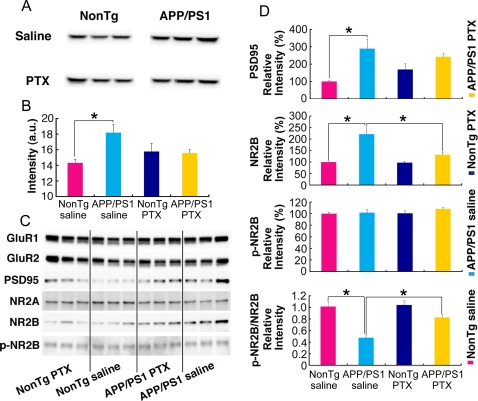
Modification of synaptic protein levels in adult APP/PS1 mice by PTX treatment.The effect of 10-day PTX treatment on the protein level of GABAA receptor α1 subunit was examined by Western blot analysis of brain homogenates. (A, B) Immunoreactivity against the GABAA receptor α1 subunit, as demonstrated by Western blotting, showed that the excess amount of this subunit in saline-treated APP/PS1 mice in comparison with the amount in saline-treated nonTg mice was absent in PTX-treated animals; *p = 0.0274, two-tailed Student's t-test. (C, D) Western blotting of membrane fractions from four groups of mice. Blots probed with antibodies against various receptors and PSD95 showed that the amounts of PSD95 and NR2B, but not other proteins, were higher in APP/PS1 mice than in nonTg mice. Because p-NR2B (NR2B phosphorylated at Tyr1472) did not differ among the four groups, the p-NR2B–to–total NR2B ratio in APP/PS1 mice was lower than that in nonTg mice. However, this difference between saline-treated nonTg and APP/PS1 mice was diminished by PTX treatment. Saline-treated nonTg mice vs. APP/PS1 mice: PSD95, *p = 0.00873; NR2B, *p = 0.00910; p-NR2B/NR2B, *p = 0.00871; two-tailed Student's t-test. Repeated measures two-way ANOVA also showed a significant difference in NR2B levels (F[1,4] = 14.32, *p = 0.0194) but not in PSD95 levels (F[1,4] = 5.27, p = 0.0834). Saline-treated APP/PS1 mice vs. PTX-treated APP/PS1 mice: NR2B, *p = 0.0383; p-NR2B/NR2B, *p = 0.0114; GABAA receptor α1 subunit, not significant p = 0.0810; PSD95, not significant p = 0.4304; two-tailed Student's t-test. Repeated measures two-way ANOVA also showed a significant difference in NR2B levels (F[1,4] = 7.72, *p = 0.0499) but not in PSD95 levels (F[1,4] = 0.31, p = 0.6070).